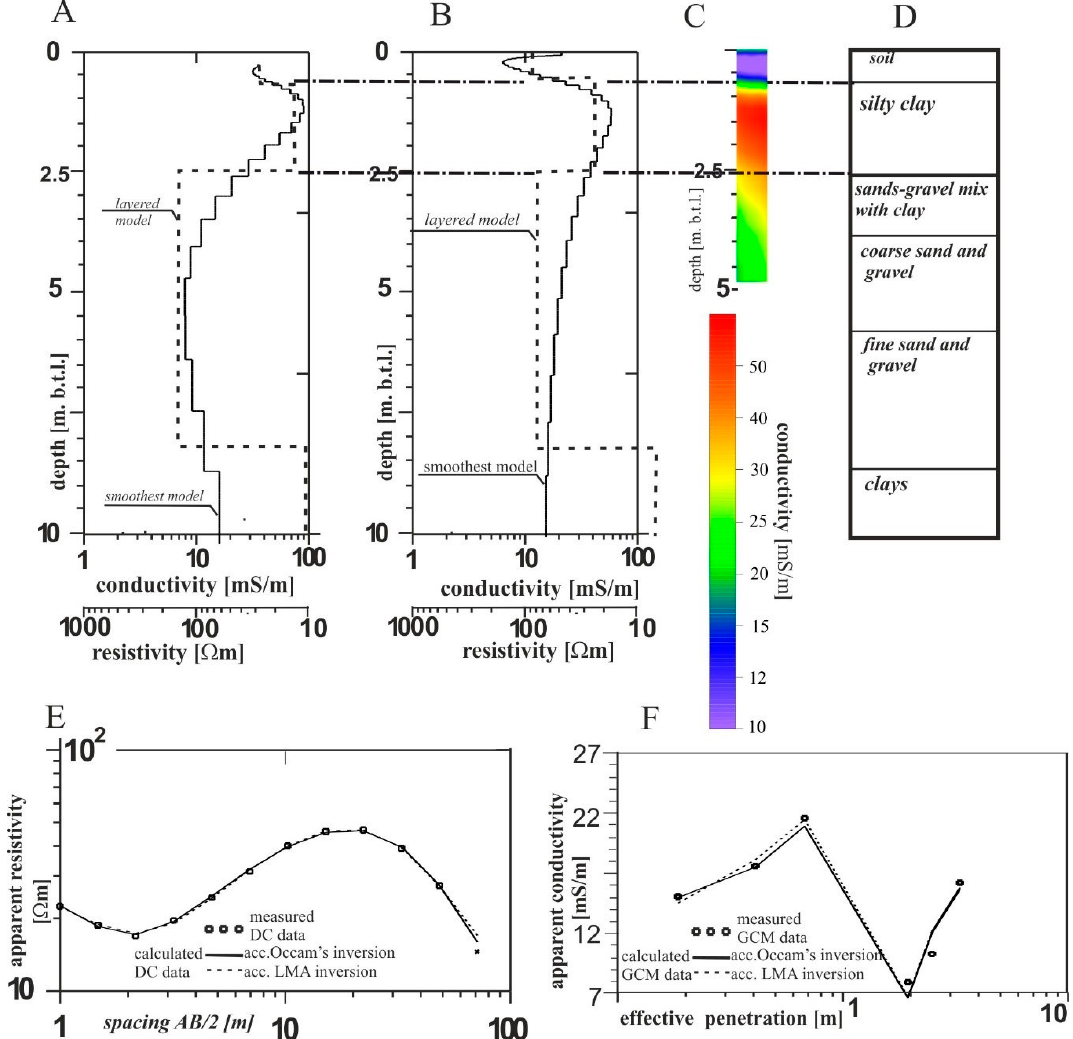
Figure 4. Results of an interpretation of location No. 1 (Figure 1) incorporating both the DC and GCM soundings and using IX1D software, A —geoelectric models obtained from the DC resistivity soundings, B —conductivity section of the DC data (for short array profiling), C —geoelectric models obtained from the GCM soundings, D —conductivity section of the GCM data (for short array profiling), E —borehole data, F —fit between the measured DC data and calculated DC data, G —fit between the measured GCM data and calculated GCM data. Correlation of the silty clay layer identified by the DC sounding and GCM sounding No. 1 (